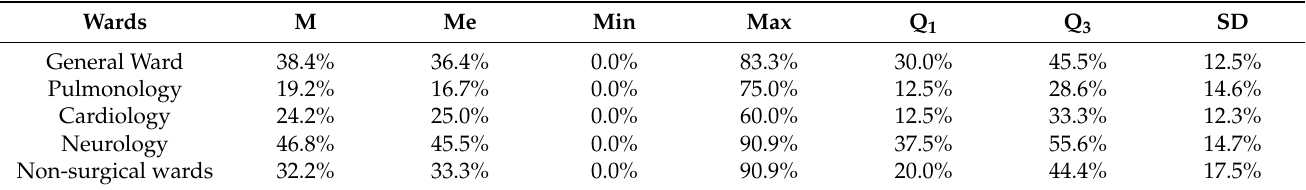
Figure 1. Histogram and data distribution model for the nursing care index (NHPpD) in non-surgical wards: ( A ) general ward, ( B ) pulmonology, ( C ) cardiology, ( D ) neurology. The percentage of nursing hours provided by nurses with higher education in non-surgical wards was 32.2% on average, with the highest value in the neurology ward (46.3%) and the lowest-in the pulmonology ward (19.2%)—Table 1. Table 1. Values of descriptive statistics for the percentage of nurses with university education over the entire period of observation in individual wards, broken down by non-surgical wards.